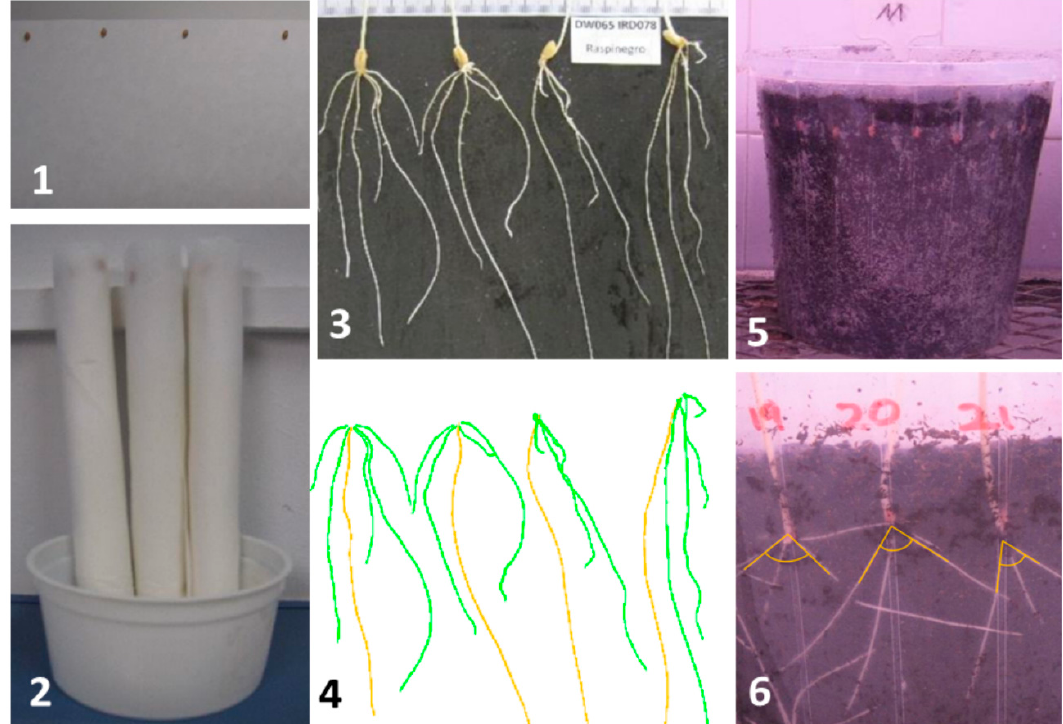
Figure 1. Experimental setup for root system architecture analysis. First, seeds were placed on humid filter paper ( 1 ) and rolled. Paper rolls were placed in plastic pots with deionized water at the bottom for root growth ( 2 ). One week after sowing, the seeds were transferred to a black surface for digital imaging ( 3 ) that were processed by SmartRoot software [22] ( 4 ). The seminal root angle was measured using the clear pots ( 5 , 6 ). Table 1. Percentage of the sum of squares of the ANOVA model for the seminal root system architecture traits in a set of 159 Mediterranean durum wheat genotypes structured into five genetic subpopulations by Soriano et al. [19].